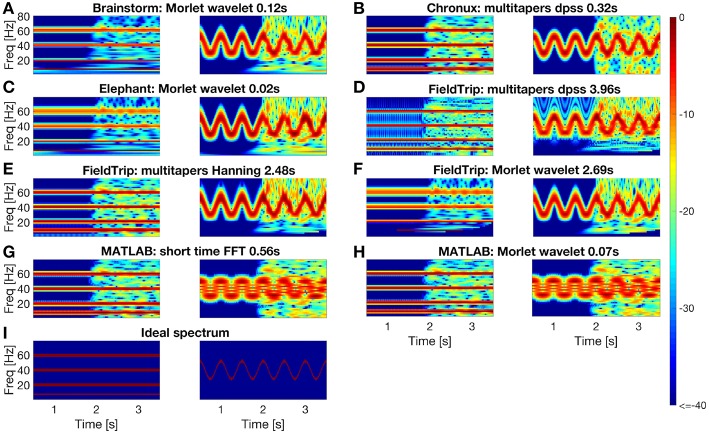
Comparing spectral analysis tools provided by the Brainstorm (A), Chronux (B), Elephant (C), FieldTrip (D–F), MATLAB (G,H) compared to ideal spectrum (I). For each toolbox we plot estimated spectrum of signal x1 (left subpanel) and of signal x2 (right subpanel). For short-time FFT we used 0.512 s moving window with 0.001s step. For multitaper methods we used in Chronux a single taper with time bandwidth product 2 (left) and 8 (right); in FieldTrip a single taper with 2 Hz (left) and 0.1F (right) frequency smoothing for time window 0.512s (left) and 8/F (right) at frequency F. For wavelet methods we used in MATLAB and Brainstorm central frequency 4 (left) and 1.5 (right) Hz; in Elephant and FieldTrip 20 (left) and 10 (right) cycles wavelets resulting in the spectral bandwidth F/10 (left) and F/5 (right) Hz at frequency F. Spectrum estimating times were averaged over 1,000 runs in MATLAB 2016a.